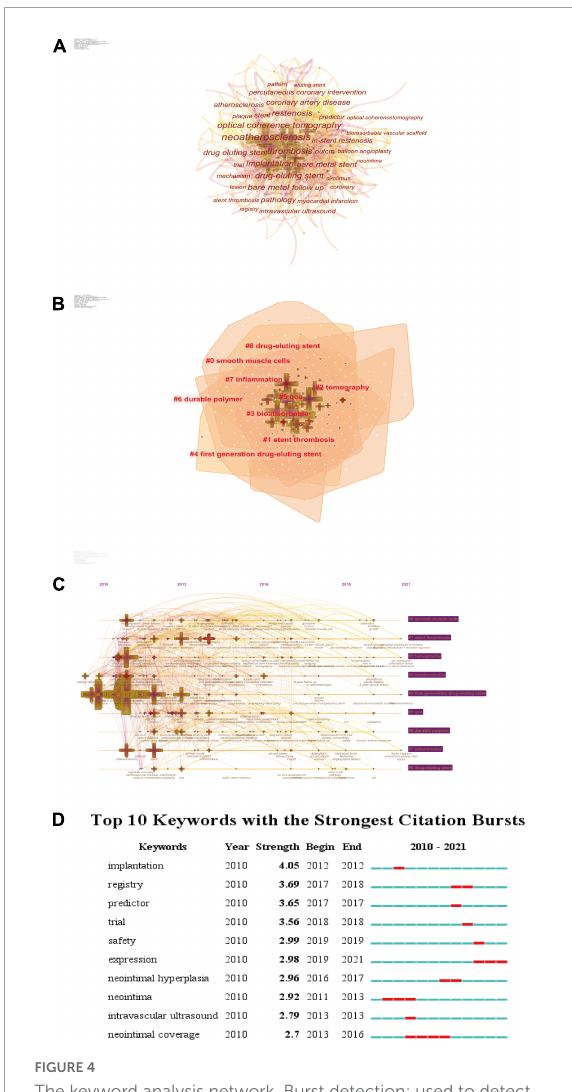
FIGURE4 The keyword analysis network. Burst detection: used to detect sudden changes in subject, literature, author, and journal citation information. (A) The network of co-occurring keywords. (B) The network of co-occurring keywords clusters based